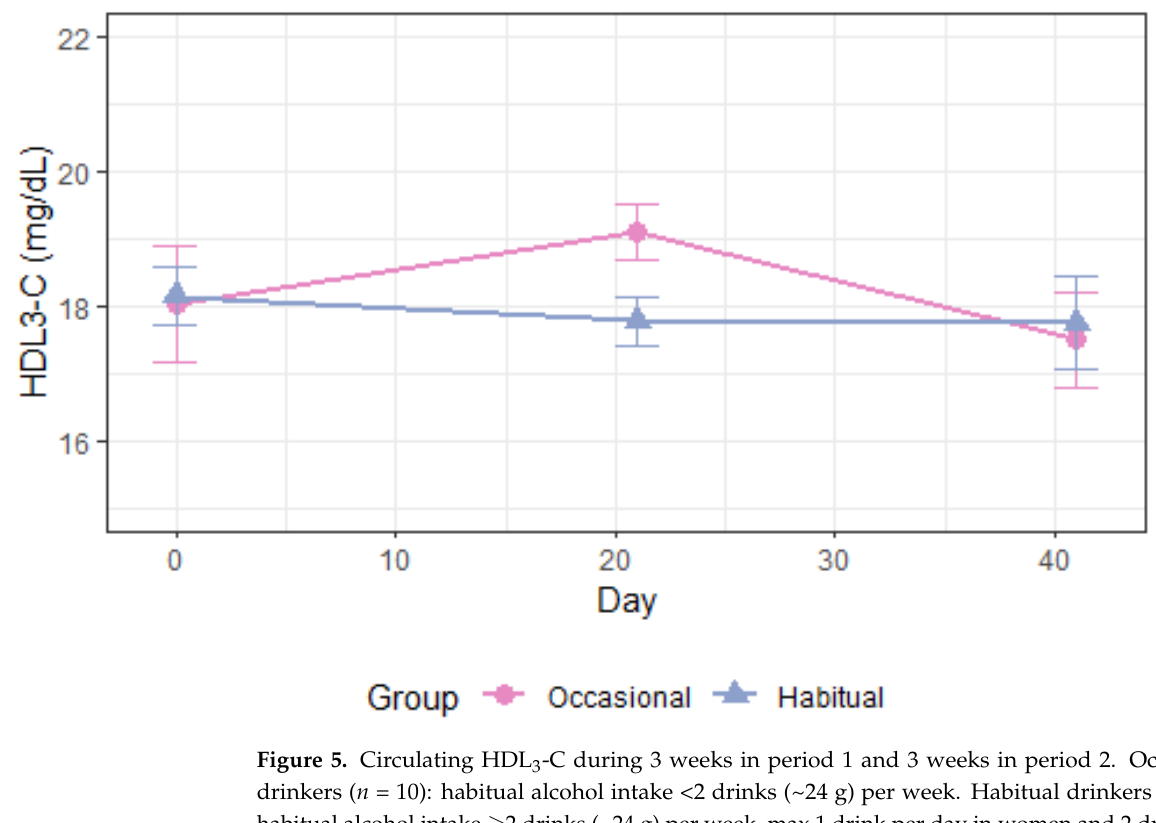
Figure 4. Circulating HDL 2a -C during 3 weeks in period 1 and 3 weeks in period 2. Occasional drink- ers ( n = 10): habitual alcohol intake <2 drinks (~24 g) per week. Habitual drinkers ( n = 16): habitual alcohol intake ≥ 2 drinks (~24 g) per week, max 1 drink per day in women and 2 drinks per day in men. -C: cholesterol concentration, HDL: high-density lipoprotein.